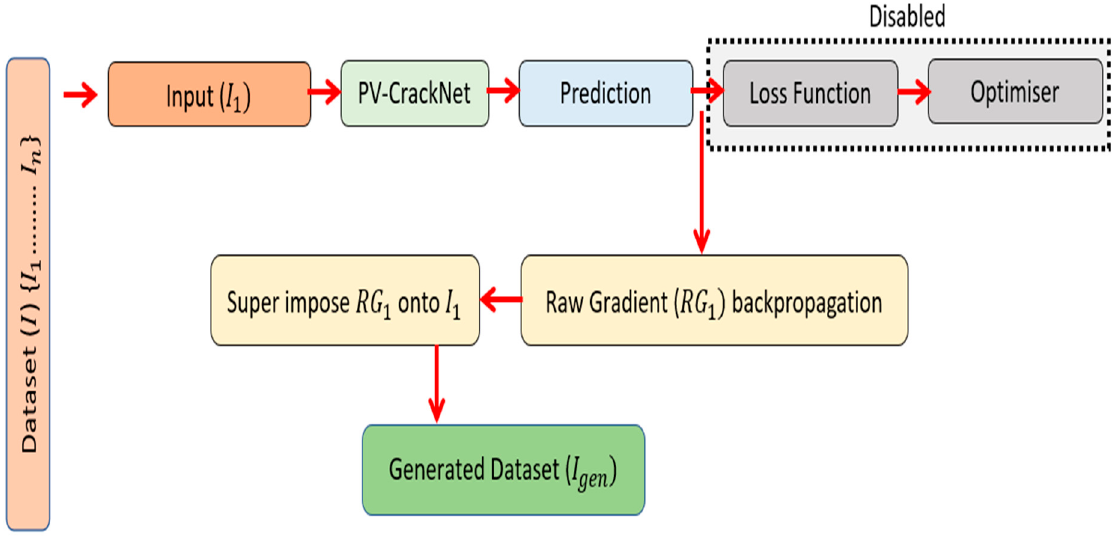
Figure 7. Filter-induced augmentation flow.